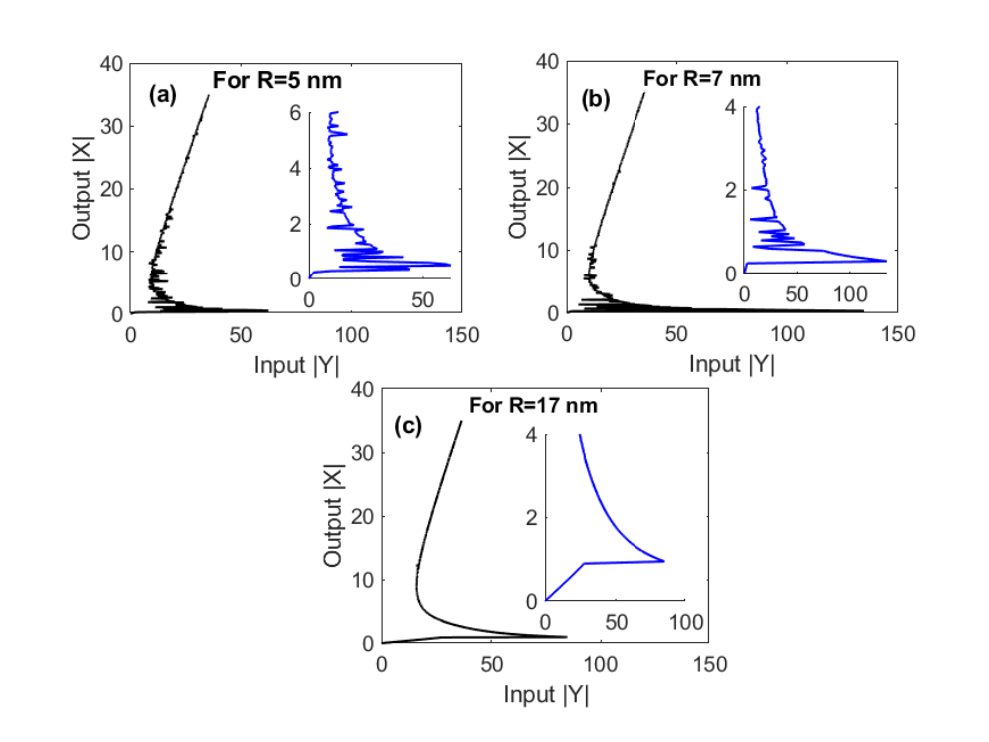
Figure 2. The output versus the input for different values of the edge-to-edge distances ( R ) between GND and MNP under electromagnetically induced transparency (EIT) conditions; = 0.4. The other parameters were and γ 32 γ 12 C = 121.36, and the mobility of GND was µ = 10 4 cm 2 /Vs.